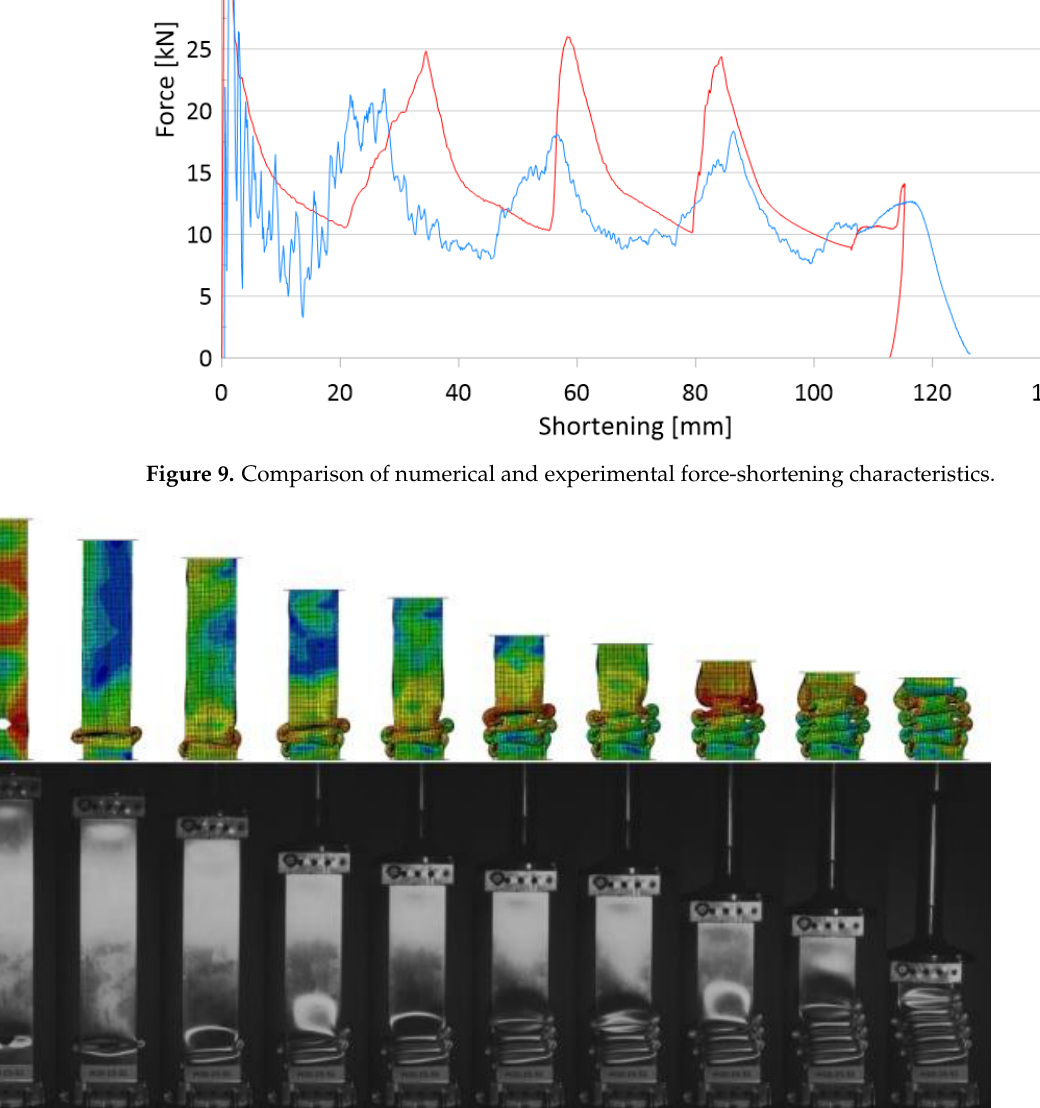
Figure 10. Modes of crushed of H10-15 thin-walled specimen.